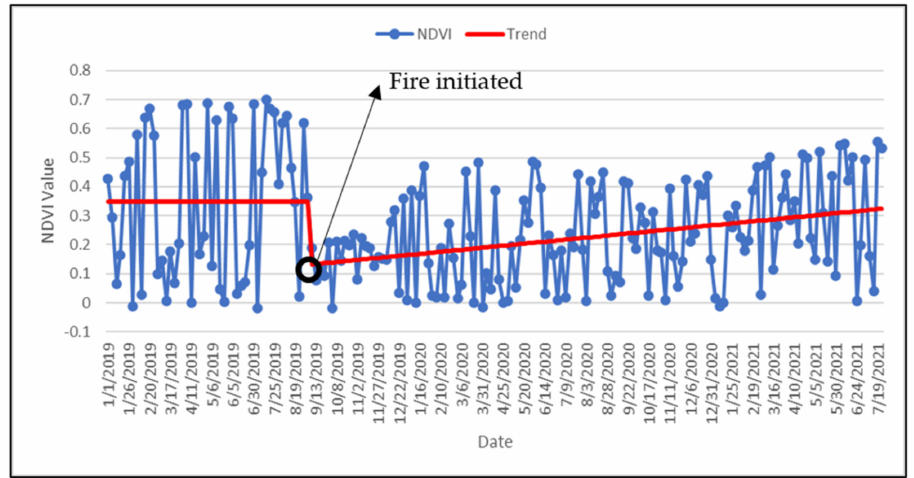
Figure 5. Monthly Normalized Difference Vegetation Index (NDVI) from January 2019 to July 2021 at Site 2, Central